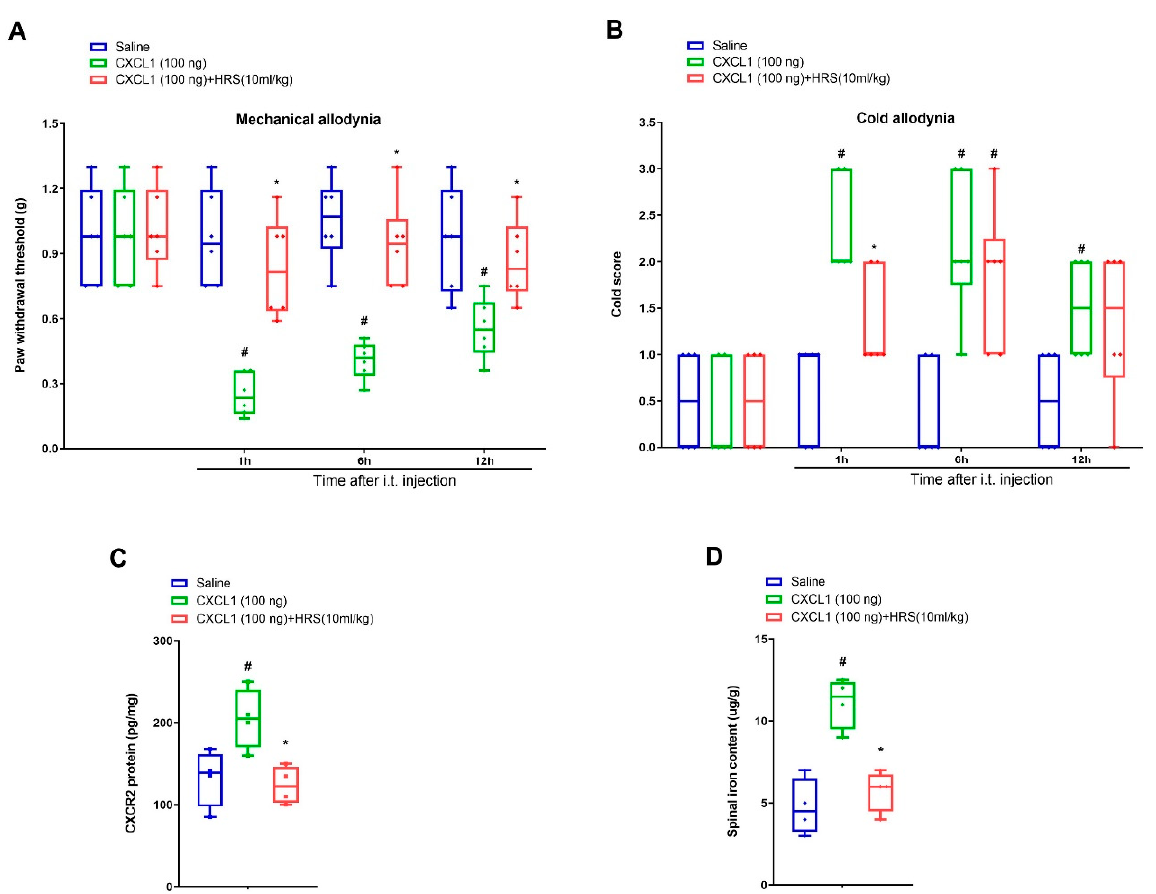
Figure 5. Exogenous CXCL1-evoked acute allodynia behaviors are ameliorated by systemic hydrogen-rich saline therapy. Recombinant CXCL1 (100 ng) was intrathecally injected in naïve animals. Intraperitoneal (i.p.) hydrogen-rich saline (HRS, 10 mL/kg) was injected 1 h prior to CXCL1 exposure. The paw withdrawal threshold ( A ) and cold responses to acetone ( B ) were documented following HRS and CXCL1 co-administration. The behavioral data ( n = 6) are analyzed by two-way ANOVA with Bonferroni post hoc comparisons. ( C ) Elisa assay showed the changes of spinal CXCR2 levels on 6 h following HRS and CXCL1 co-administration. ( D ) Spinal iron concentration on 6 h following HRS and CXCL1 co-administration was measured using atomic absorption spectrophotometer. The biochemical data ( n = 4) are analyzed by one-way ANOVA with Bonferroni post hoc comparisons. Results are expressed as medians with interquartile ranges and individual data plots. # p < 0.05 vs. group Saline, * p < 0.05 vs. group CXCL1 (100